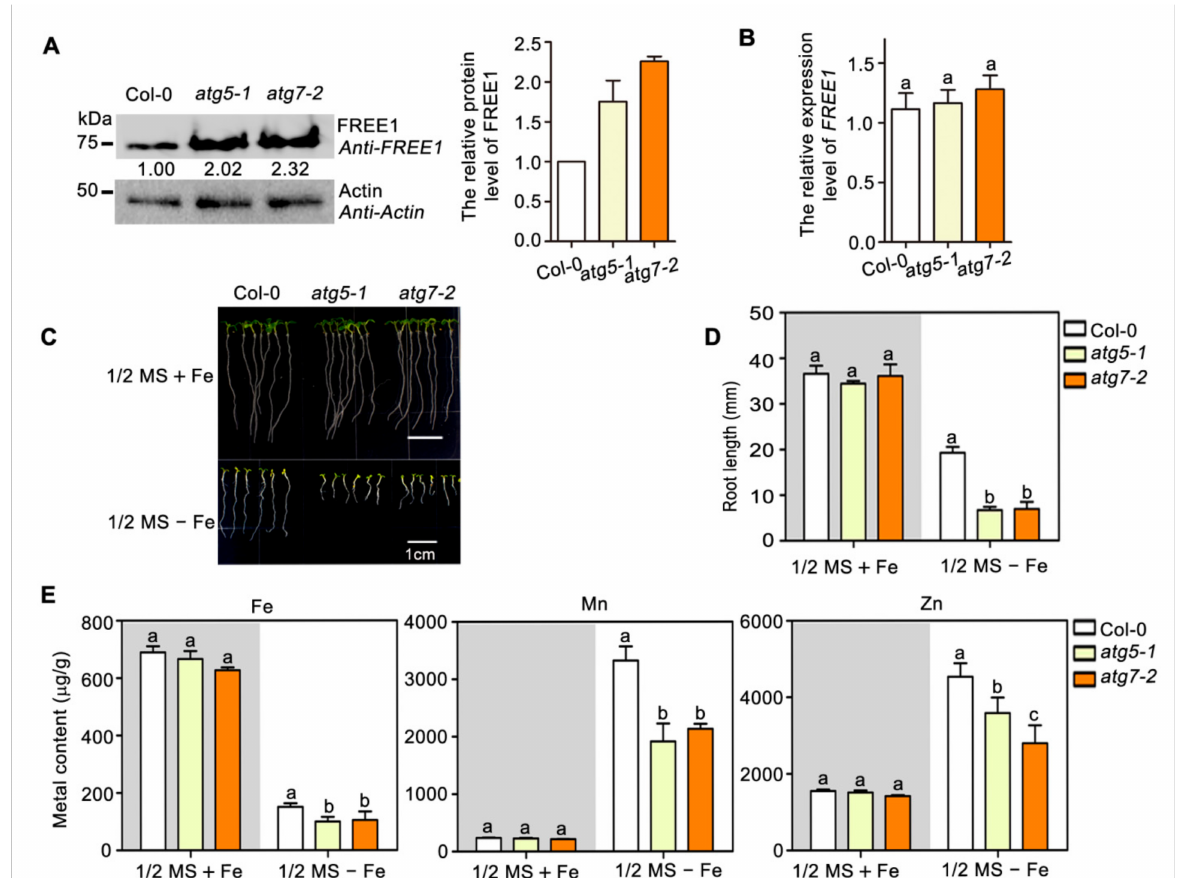
Figure 2. Autophagy positively regulates metal uptake under iron-deficient growth conditions. ( A ) Immunoblot-detection of endogenous FREE1 in 7-d-old Col-0, atg5-1 and atg7-2 seedlings. The numbers below the corresponding bands were relative grayscale intensities of FREE1 normalized to actin. Quantification of the relative grayscale intensities of FREE1 from three independent experiments was shown in the right panel. ( B ) qRT-PCR analysis of FREE1 expression levels among the Col-0, atg5-1 and atg7-2 mutants. UBQ10 was used as an internal control for qRT-PCR analysis. ( C ) Phenotypes of Col-0, atg5-1 and atg7-2 vertically grown for 7 d on 1/2 MS + Fe (upper panel) and 1/2 MS − Fe (lower panel) medium plates. ( D ) Root length in forementioned seedlings ( C ). Data are represented as mean ± SD of 20 seedlings from three replicates. ( E ) Metal content was determined by ICP-MS of 12-d-old seedlings grown on 1/2 MS + Fe and 1/2 MS − Fe medium plates. Results are presented as mean ± SD from three batches of seedlings, each batch weighing 0.5 g in fresh weight. Statistical differences were calculated by one-way ANOVA. Different letters indicate means that were statistically different by Tukey’s multiple testing methods ( p < 0.05) for genotypes within a given growth